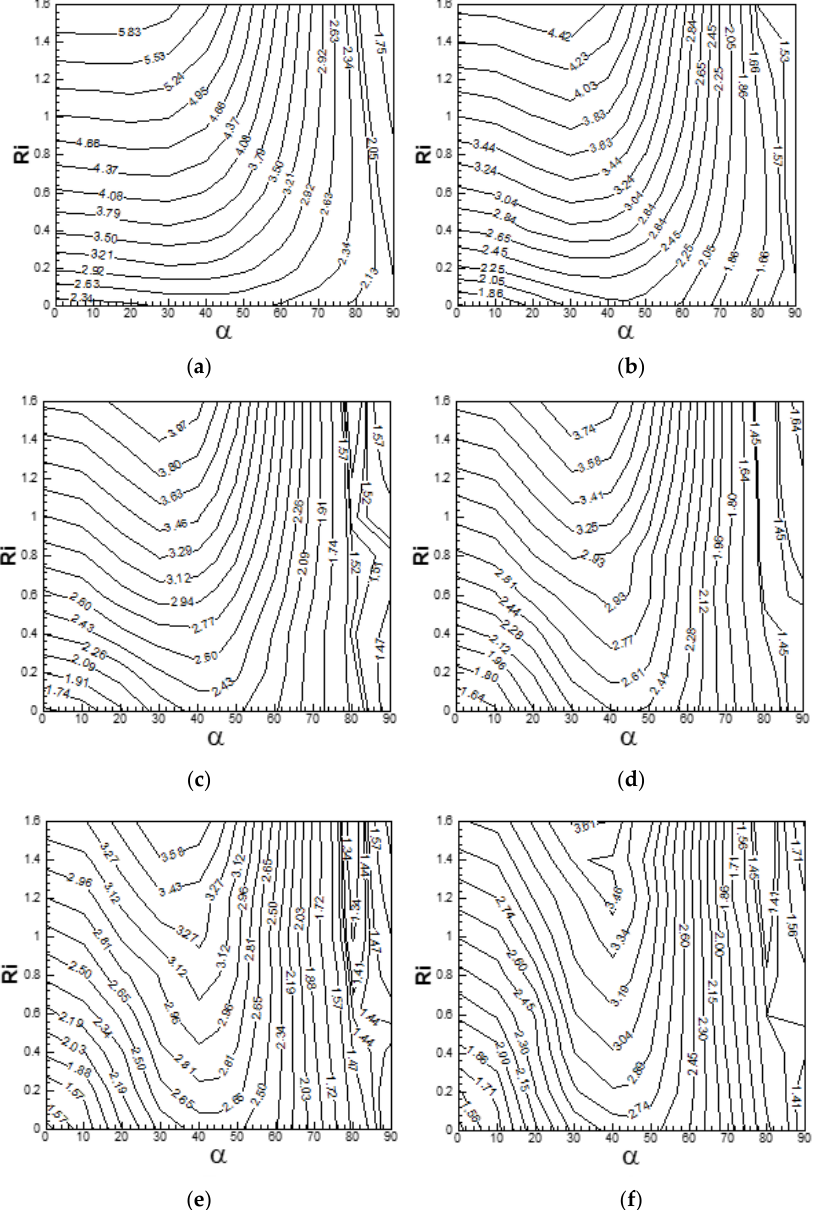
Figure 34. Contour maps of mean/steady drag coefficient ( D C ) in α— Ri plane at ( a ) Re = 20, ( b ) Re = 40, ( c ) Re = 60, ( d ) Re = 80, ( e ) Re = 100 and ( f ) Re = 120.